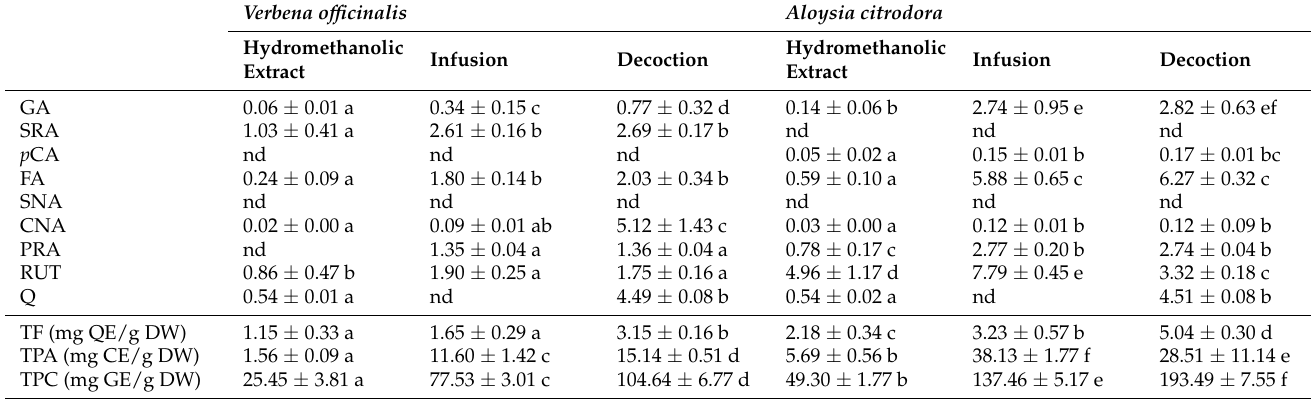
Table 4. The results of the individual phenolic compound (mg/g DW) and total flavonoid (TF), phenolic acid (TPA) and phenolic content (TPC) of the hydromethanolic extract, infusion, and decoction of Verbena officinalis and Aloysia citrodora